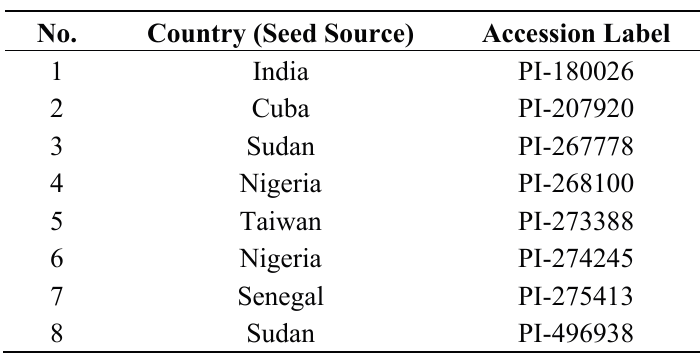
Table 4. Investigated leaves of eight different accessions of H. sabdariffa . The plant identification (PI) numbers of accession label were assigned by the United States Department of Agriculture-Agricultural Research Service